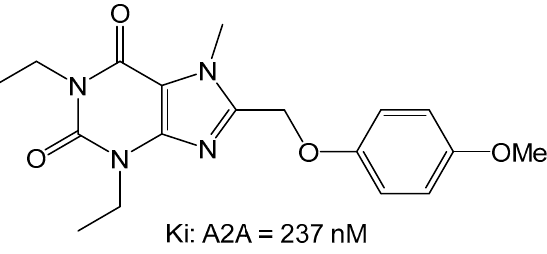
Figure 11. Phenoxymethyl-xanthine derivatives which are dual A 1 /A 2A antagonists [35].